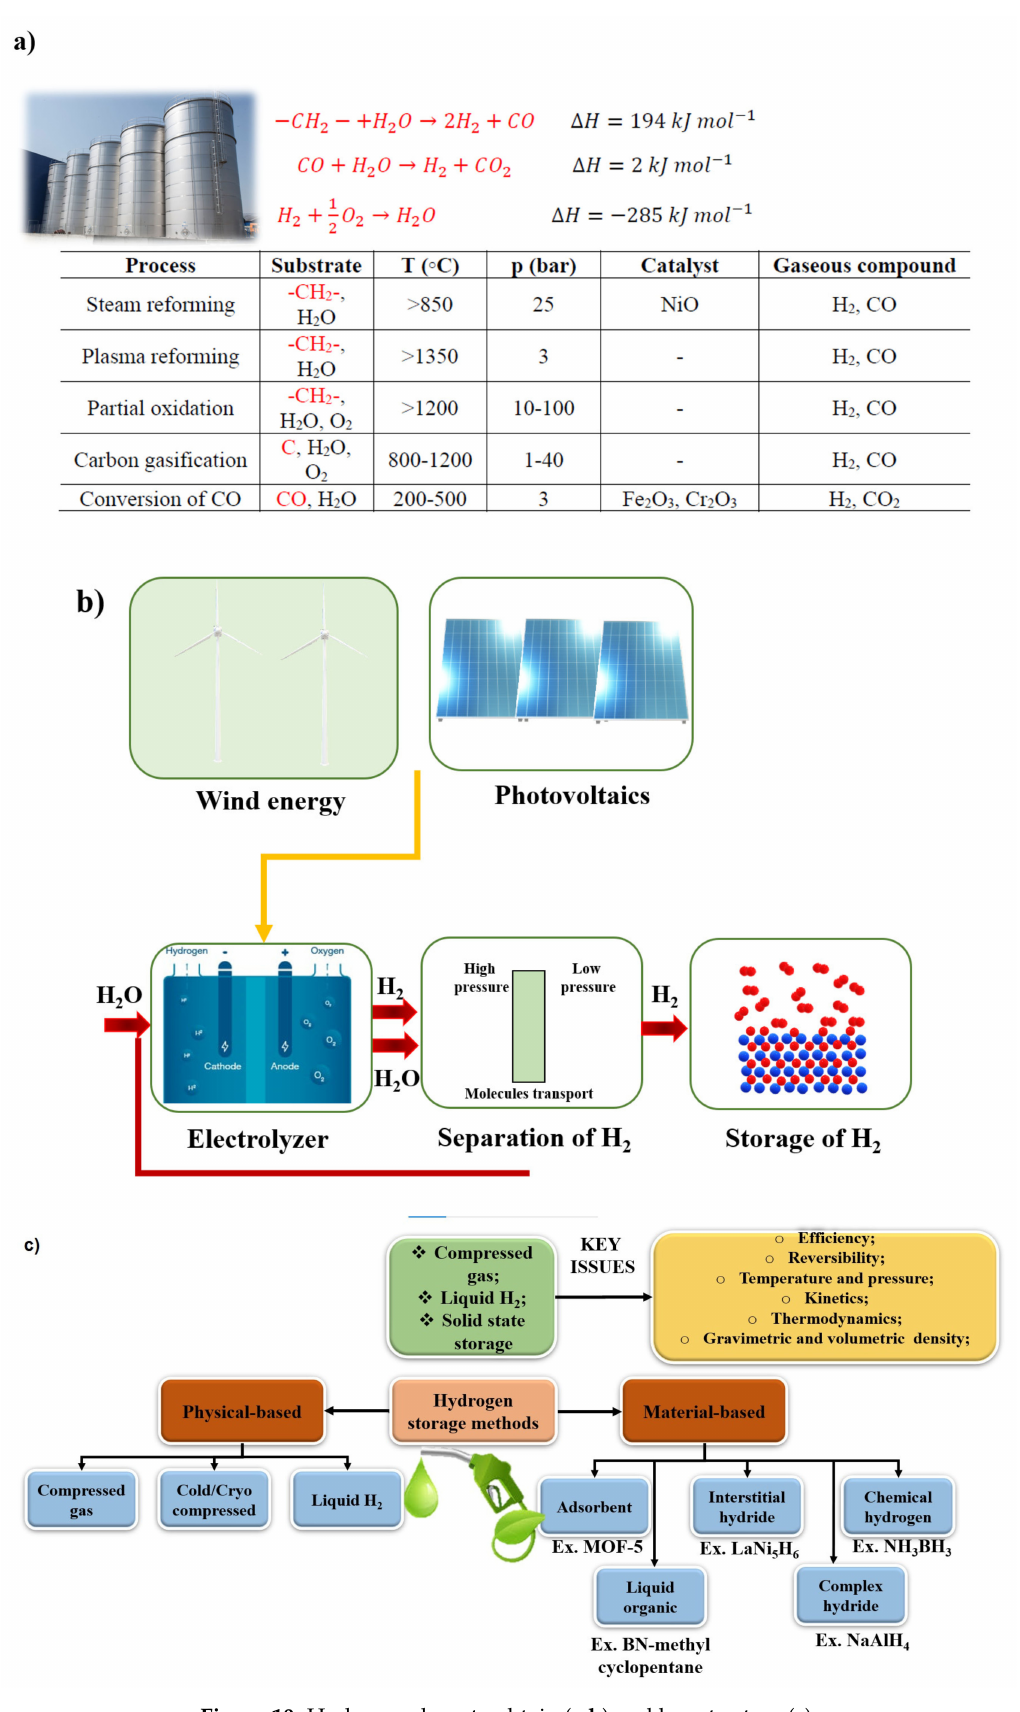
Figure 10. Hydrogen: how to obtain ( a , b ) and how to store ( c